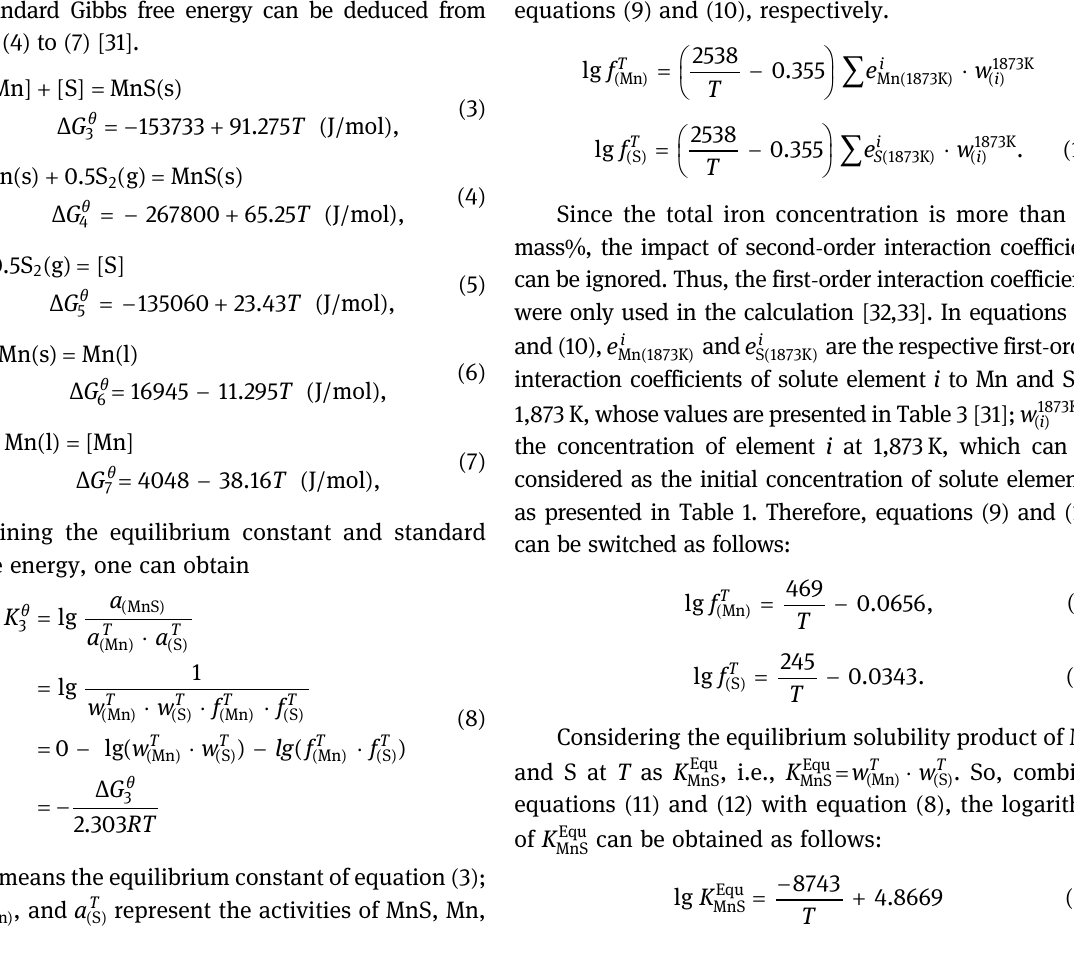
Table 3: First - order interaction coefficients between elements in molten steel at 1,873 K [ 31 ] C Si Mn O Mn − 0.07 S